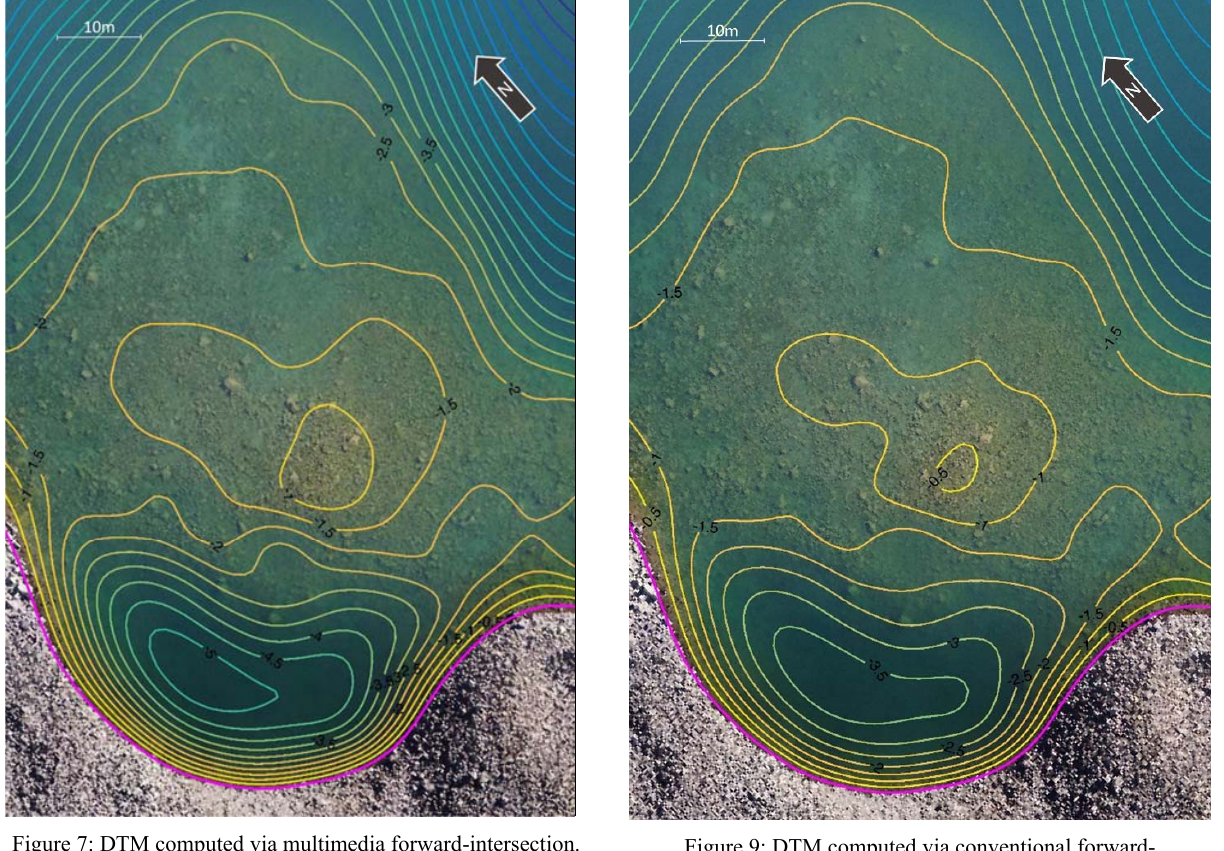
Figure 9: DTM computed via conventional forward- intersection. Note that the depth range was